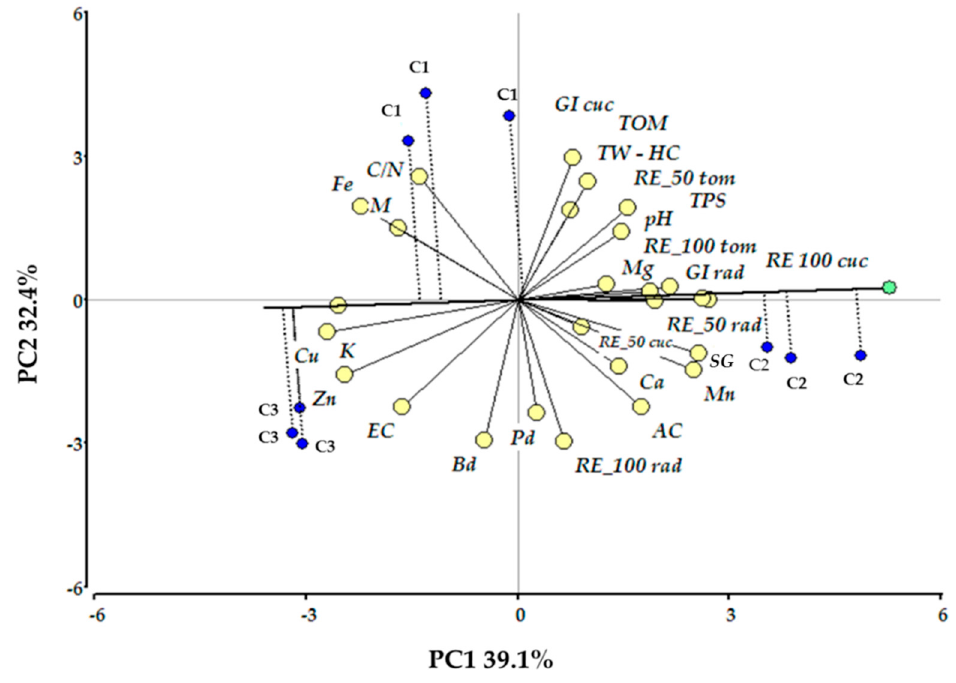
Figure 5. Principal component analysis (PCA) of C1, C2 and C3 corresponding to the 18 weeks.